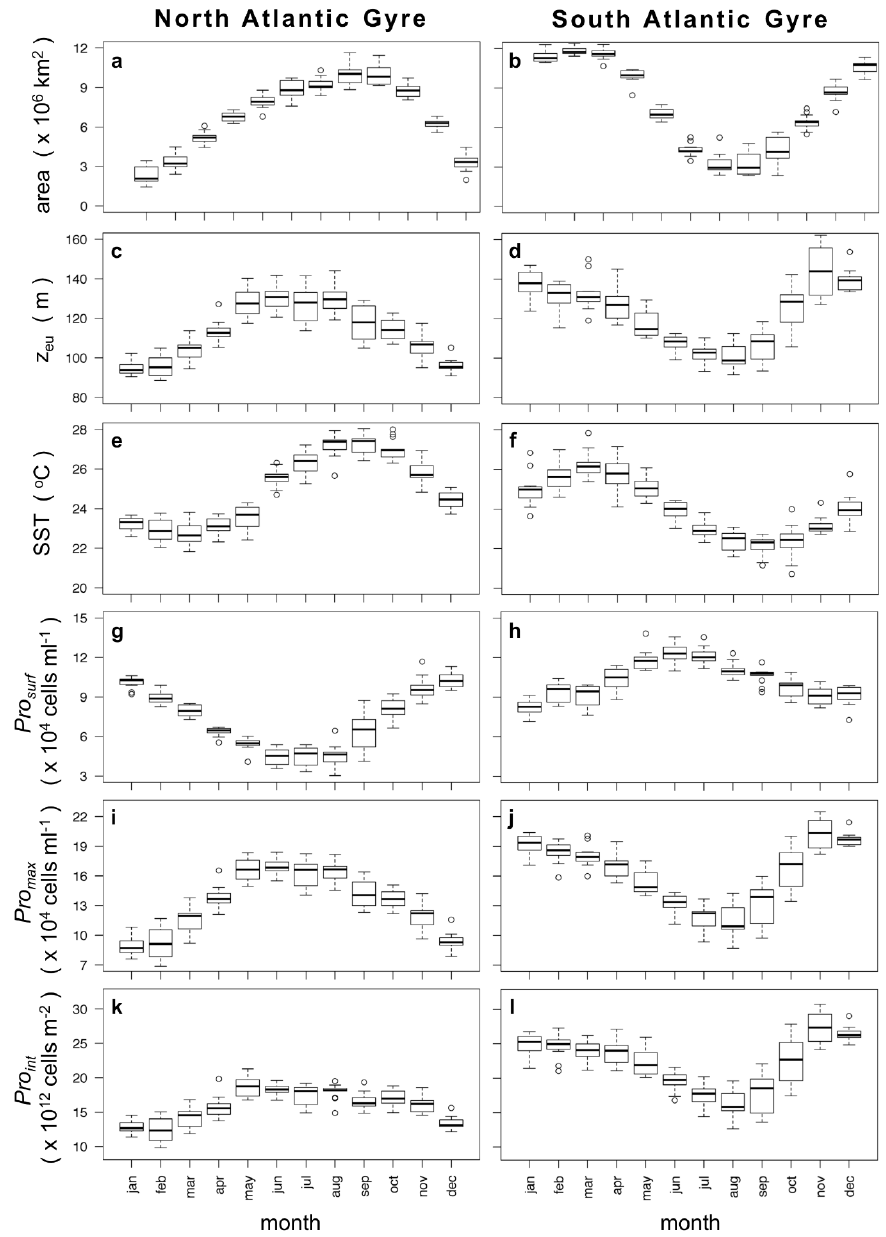
Figure 9. Monthly averages of ( a ) the areal extent of the North Atlantic Gyre (NAG) and ( b ) South Atlantic Gyre (SAG); ( c ) the euphotic depth z eu at the NAG and ( d ) the SAG; ( e ) sea surface temperature SST at the NAG and ( f ) the SAG; ( g ) the estimated Prochlorococcus cell abundance at the sea surface ( Pro surf ) at the NAG and ( h ) the SAG; ( i ) Prochlorococcus cell abundance at the deep maximum ( Pro max ) at the NAG and ( j ) the SAG; and ( k ) Prochlorococcus cell abundance integrated in the water column ( Pro int ) at the NAG and ( l ) the SAG. Subtropical Gyres were defined as regions where the surface chlorophyll concentrations were lower than 0.075 mg m −3 . The euphotic depth was estimated using the calculated K d PAR using Equation (1), and SST measurements were taken from monthly satellite composites from January 2003 to December 2014 [22]. Prochlorococcus cell abundance was computed using monthly averaged input variables for the years 2003 – 2014 [22], at specific locations inside the Atlantic gyres: NAG: 26° N, 50° W; SAG: 20° S, 20° W.